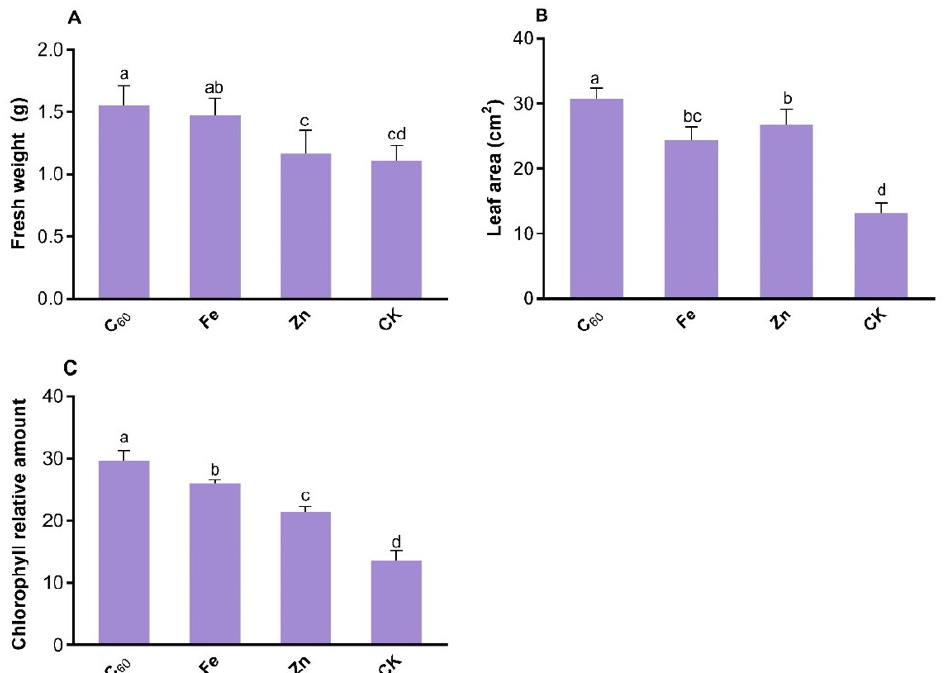
Figure 2. Effect of foliar application of carbon and metal-based nanoparticles (100 mg L − 1 ) on N. benthamiana , ( A ) fresh weight, ( B ) leaf area, and ( C ) chlorophyll relative amount after the inoculation of CCYV: GFP (n = 4). Lowercase letters are Nanoparticle formula. Fullerene (C60).